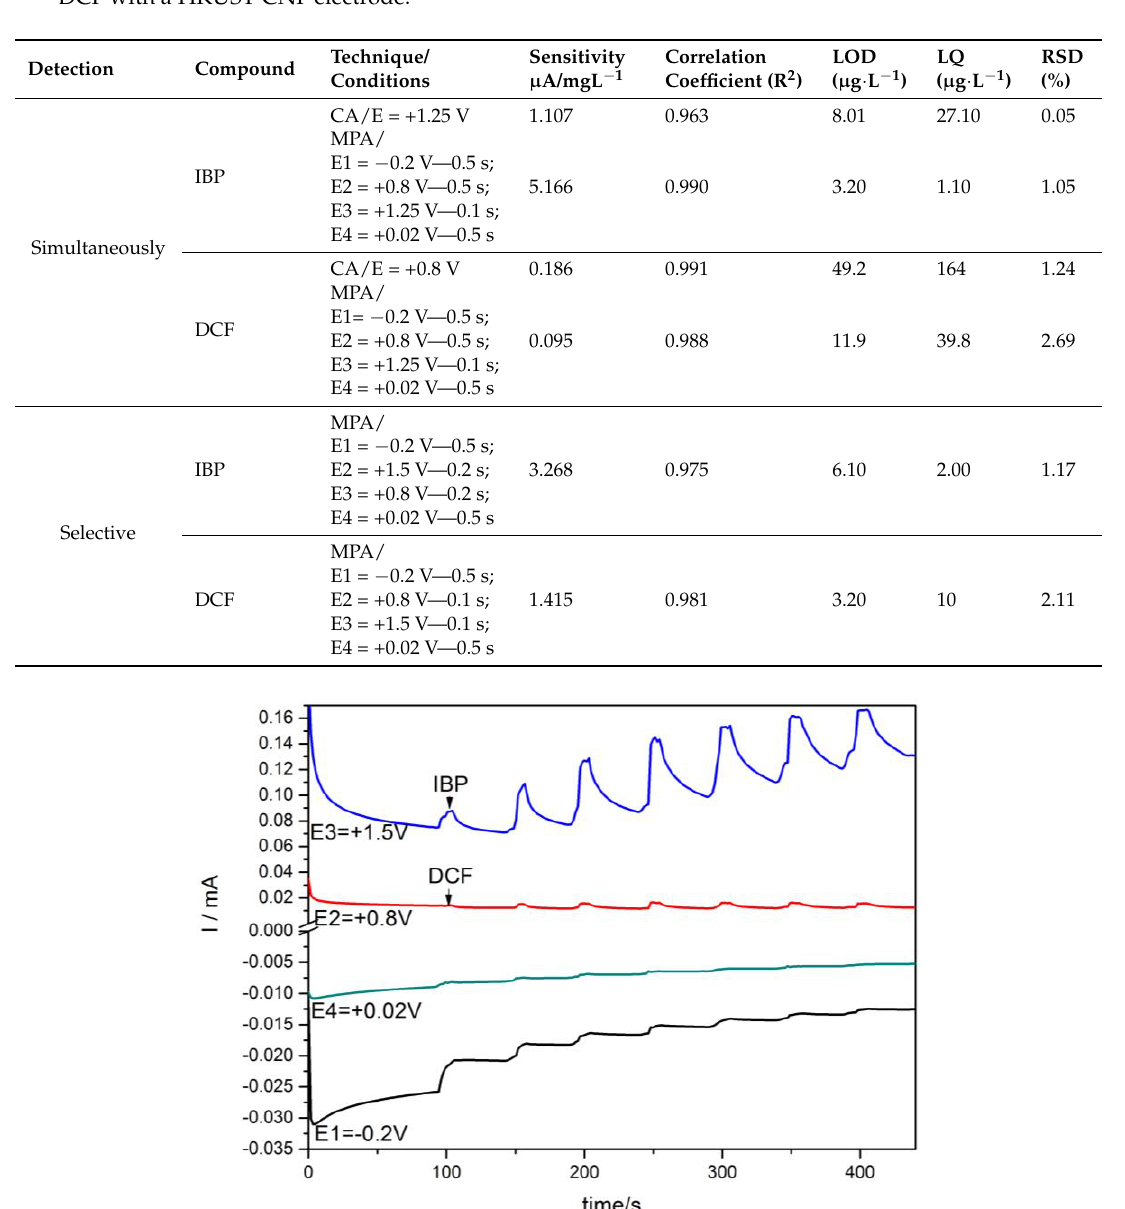
Figure 7. Multiple-pulsed amperograms recorded with a HKUST-CNF electrode in 0.1 M Na 2 SO 4 supporting electrolyte and continuously adding a mixture of 2 mg·L −1 DCF and 2 mg·L −1 IBP, recorded at E1 = −0.2 V/SCE (time duration of 0.5 s), E2 = +0.8 V/SCE (time duration of 0.5 s), E3 = +1.25 V/SCE (time duration of 0.1 s), E4 = +0.02V/SCE (time duration of 0.5 s).